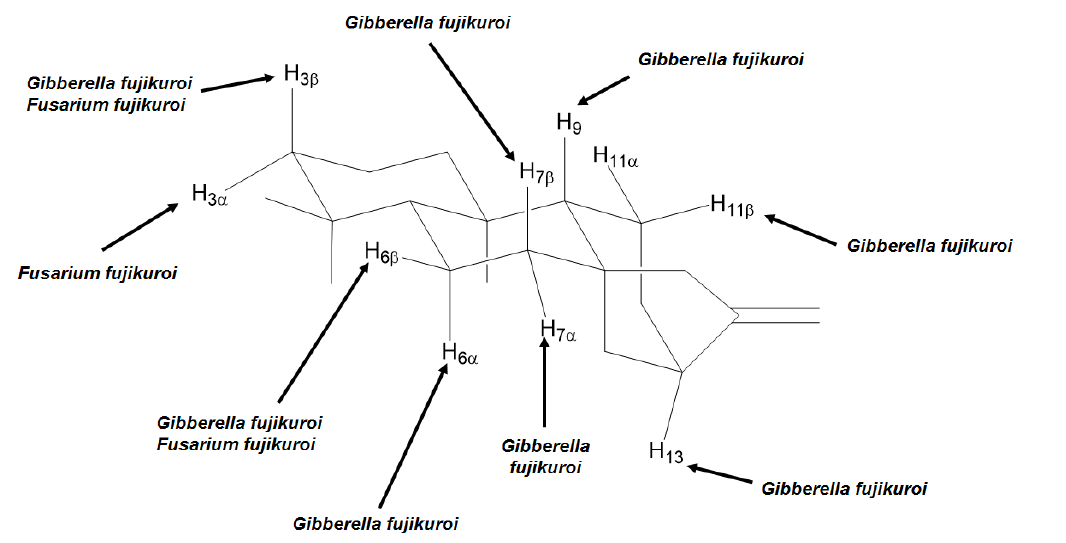
Figure 4. Positions and orientations of hydroxyl groups added to kaurane diterpenes by biotransformations using fungi from G. fujikuroi